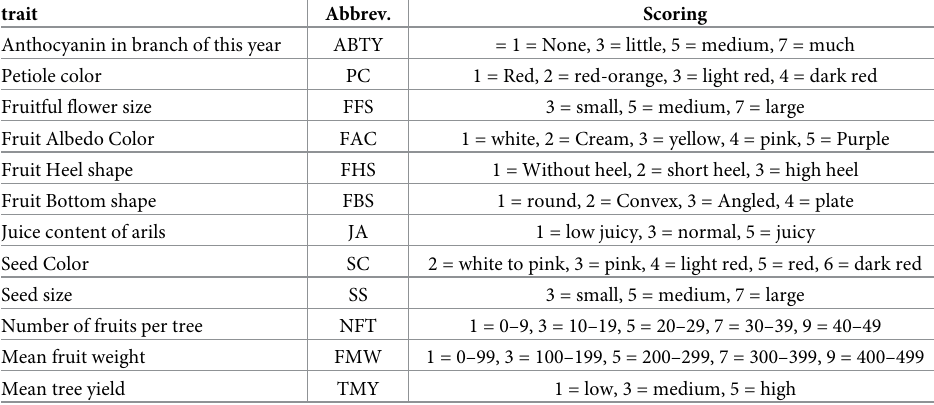
Table 1. Scoring morphological traits of pomegranate. trait